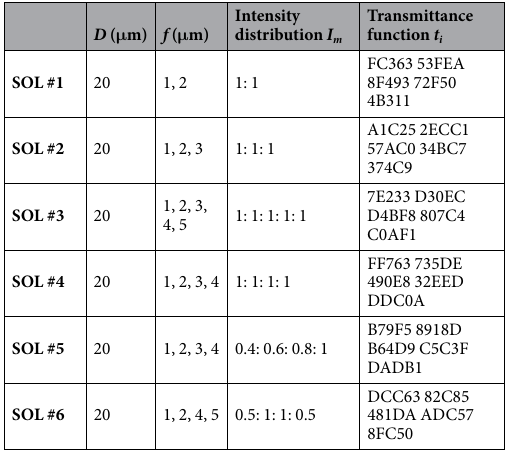
Table 1. Targeted parameters and transmittance functions of the optimized binary amplitude-type SOLs.